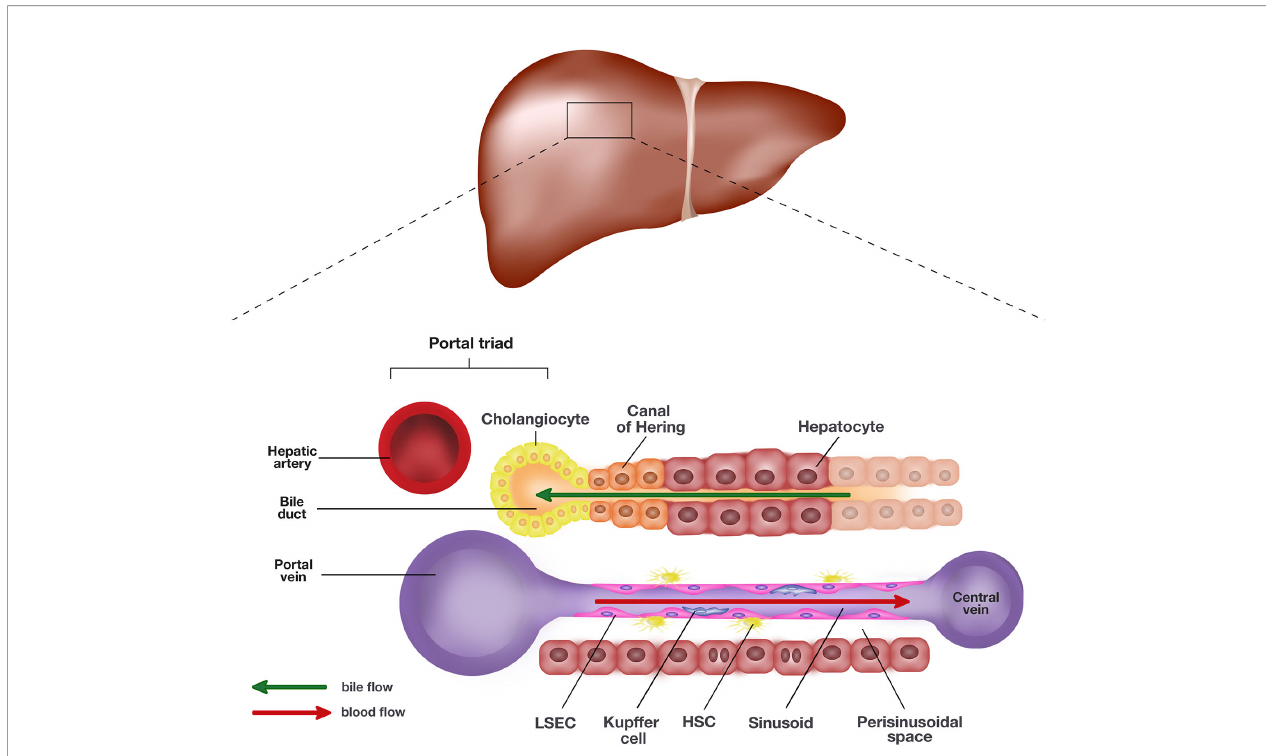
FIGURE 1 | Schematic representation of the liver and the single end of its lobule. The portal triad comprising the hepatic artery, bile duct, and portal vein sits at each end of the hepatic lobule. Blood collected from the portal vein and hepatic artery fl ows toward the central vein through the hepatic sinusoids lined by liver sinusoidal endothelial cells (LSEC) and hepatocytes. The hepatocytes and LSECs are separated by the perisinusoidal space, also known as space of Disse ́ where hepatic stellate cells (HSC) are located. The hepatocytes produce bile which empties into the bile duct lined by cholangiocytes. The canal of Hering is positioned in the junctional region between cholangiocytes and hepatocytes, where liver progenitor cells (LPC) are proposed to